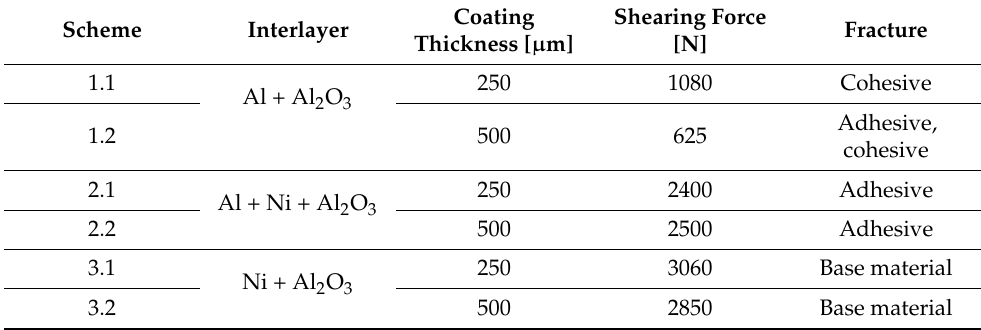
Table 2. Results of steel-aluminium tensile shear force measurements of RSW joints